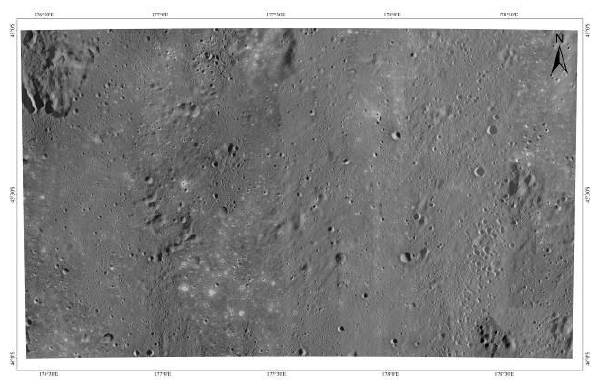
Figure 4. A high-resolution LROC NAC DOM mosaic of CE-4 landing site region in Lambert conformal conic